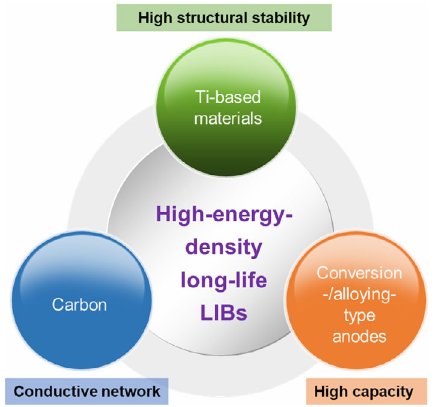
Fig. 1 Schematic illustration of capacity enhancement protocol for Ti-based